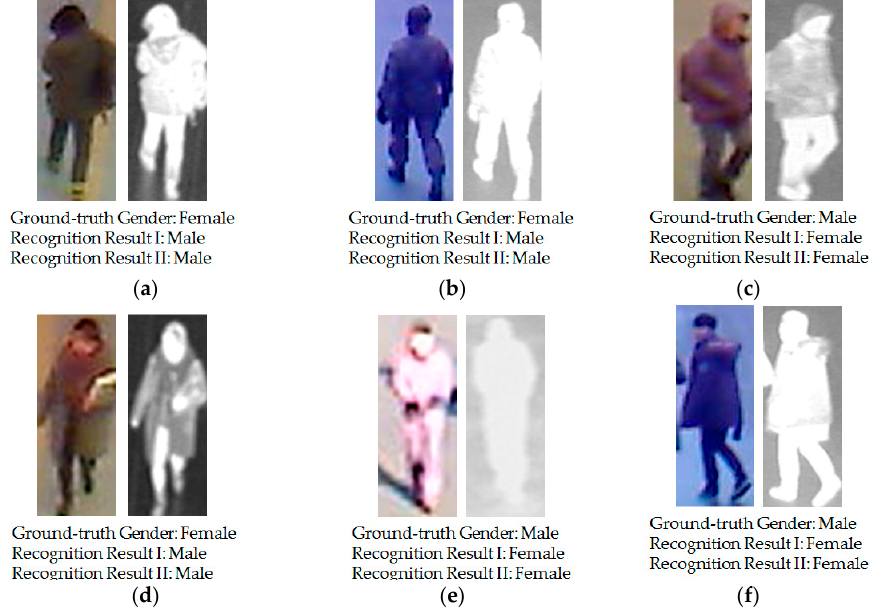
Figure 10. Example of recognition results of our proposed method where the error cases were occurred: ( a , b ) female images in back view; ( c , f ) male images in side view; ( d ) female image in front view; and ( e ) male image in front view.